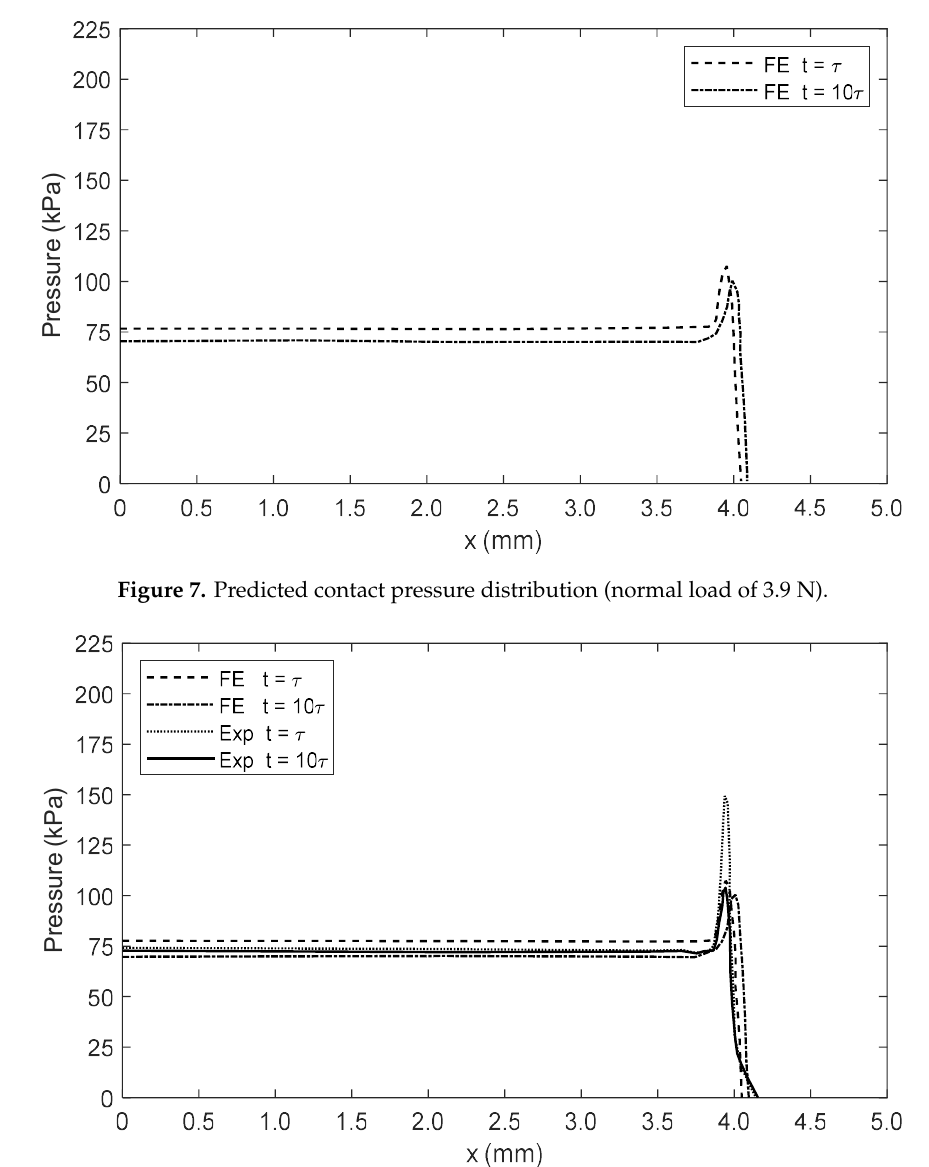
Figure 8. Comparison of predicted and measured contact pressures.